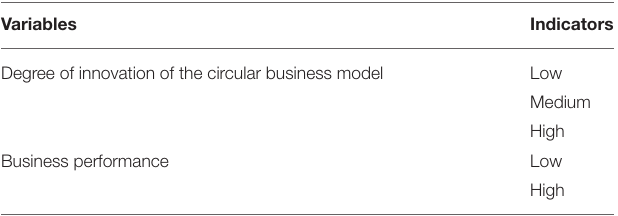
TABLE 4 | Measures of discrimination of correspondence